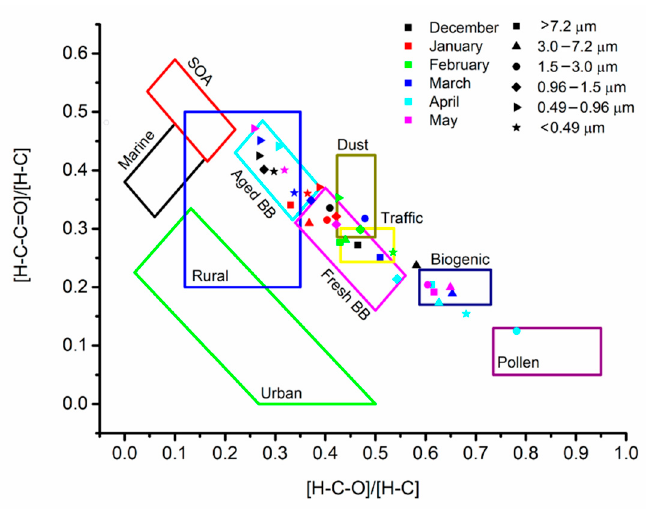
Figure 3. Functional group distribution diagram of water-soluble organic carbon.